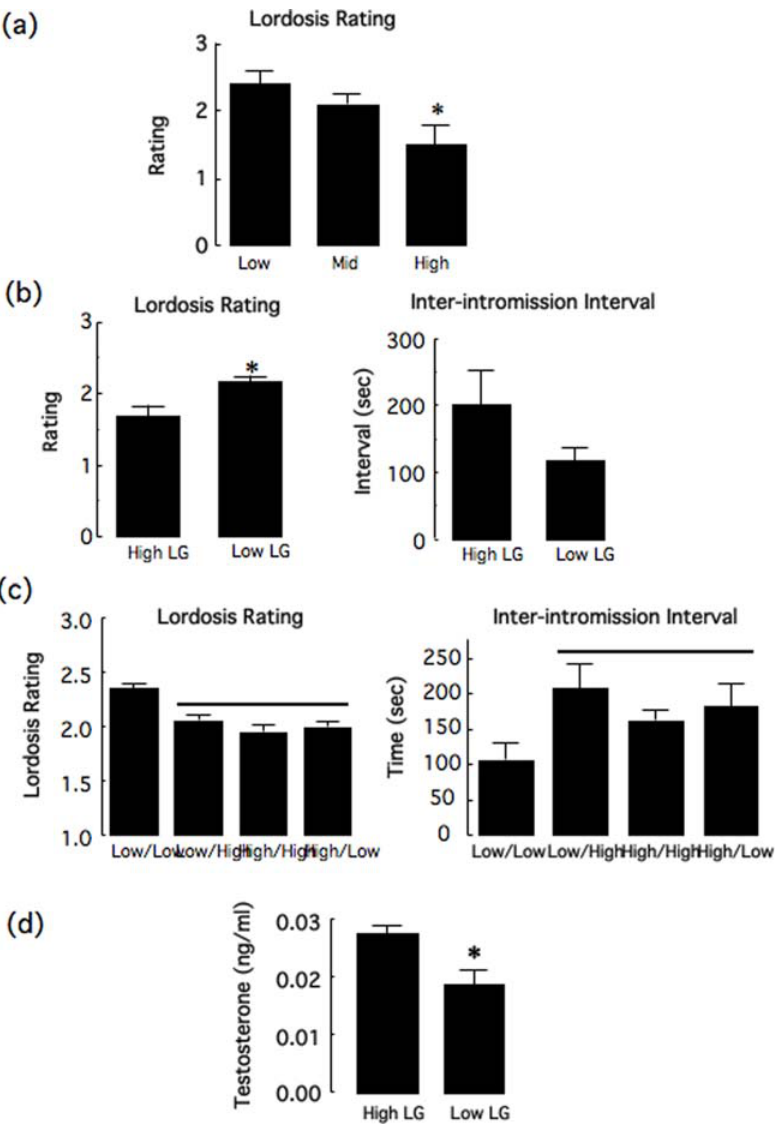
Figure 1. Mating behavior of the female offspring and the effect of cross-fostering. (a) Tested with a stud male in a small traditional testing arena, the mean ( 6 SEM) lordosis rating in the adult female offspring of High LG mothers was lower compared to Low and Mid offspring (n=10–12/group).* p , 0.05. (b) Tested in a pacing chamber, the mean ( 6 SEM) lordosis rating of adult female offspring of High LG mothers was lower compared to Low female offspring. * p , 0.05. The inter-intromission interval showed no significant differences (n=12/group). (c) Mean 6 SEM lordosis rating or inter-intromission interval in the adult female offspring of Low or High LG mothers fostered to and reared by Low (Low-Low; High-Low) or High (Low-High; High-High) tested with a stud male in the pacing chamber (n=7–13/group). Groups lying underneath the line differ significantly ( p , 0.05) from the Low-Low group. (d) Mean 6 SEM testosterone level in amniotic fluid of embryonic day 20 female offspring of High or Low LG mothers (n=20–25 pups from 12–14 litters/group; *p ,